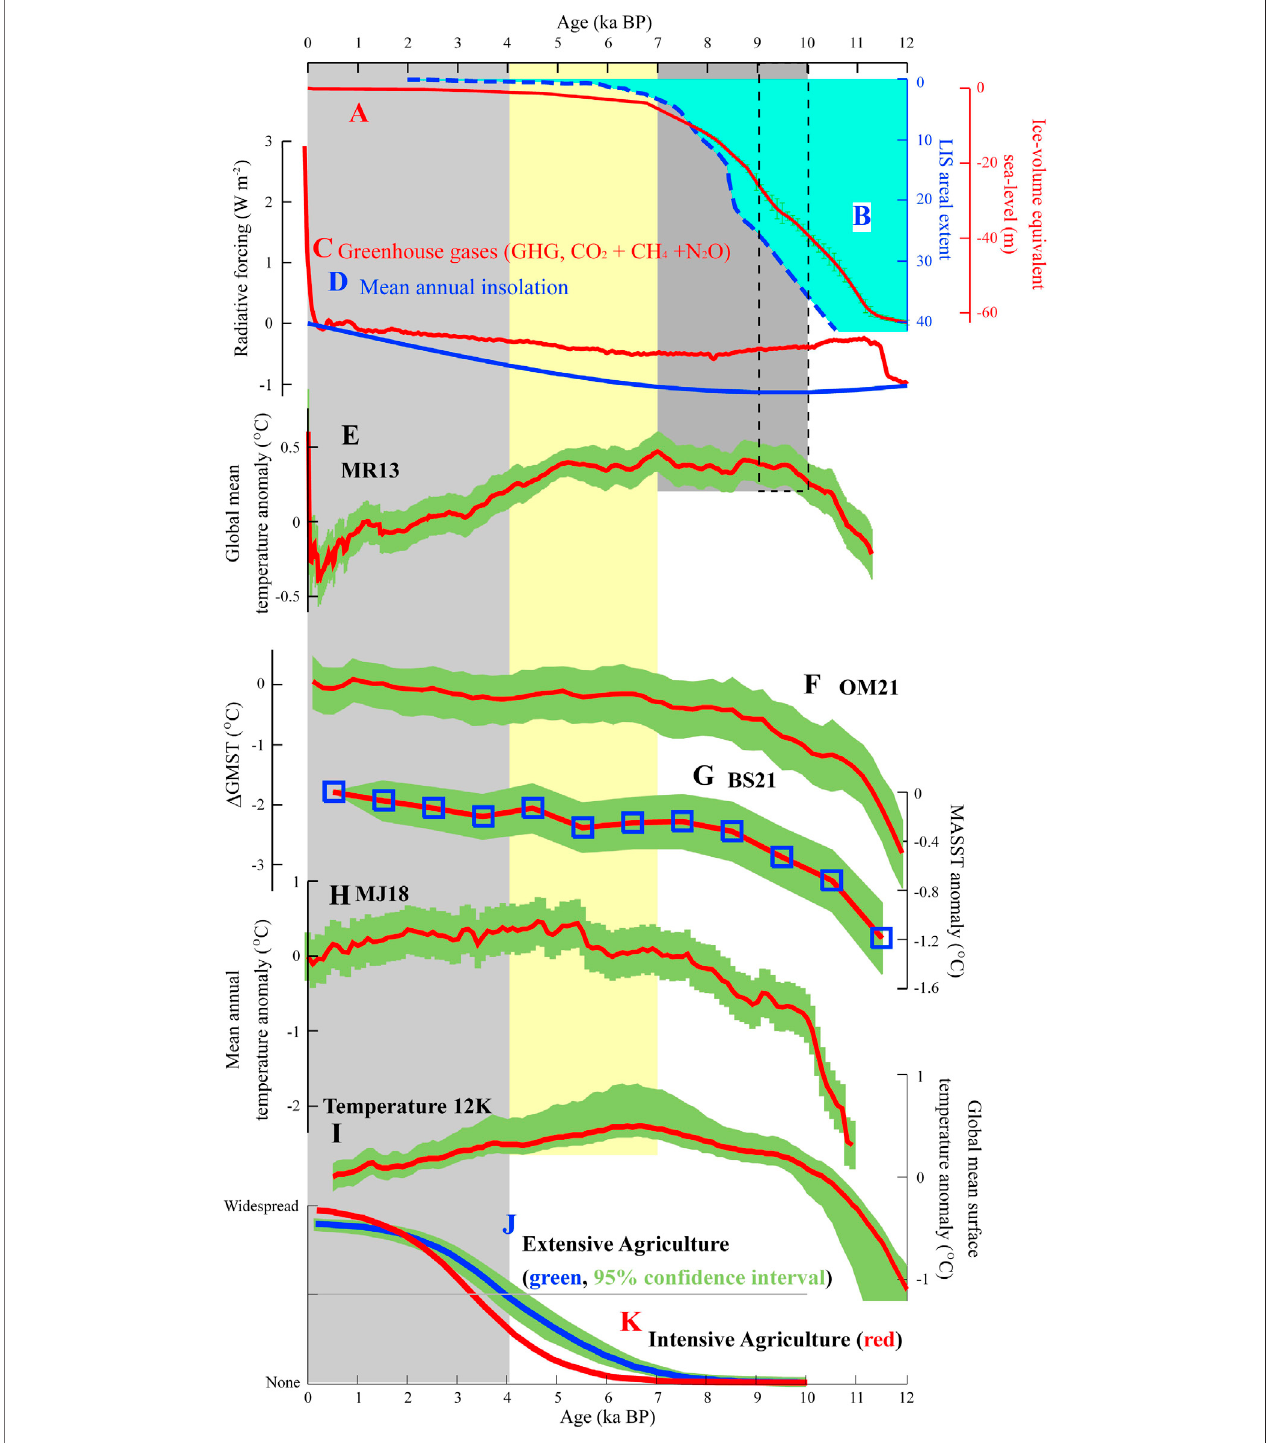
FIGURE4| ComparisonofselectedHolocenepaleotemperatureandpaleoenvironmentalrecords: (A) ,Globallystackedice-volumeequivalentsea-level(Lambeck et al., 2014); (B) , LIS areal extent (Dyke, 2004); (C) , GHG radiative forcing (Köhler et al., 2017); (D) , mean annual insolation radiative forcing (Berger, 1978); (E) , MR13 temperature stack (Marcott et al., 2013); (F) , OM21 temperature stack (Osman et al., 2021); (G) , BS21 temperature stack (Bova et al., 2021); (H) , MJ18 temperature stack (Marsicek et al., 2018); (I) , Temperature 12K record (Kaufman et al., 2020a); (J) , Globally estimated spatial expansion of the extensive agriculture (Stephens et al., 2019); (K) , Globally estimated spatial expansion of the intensive agriculture (Stephens et al., 2019).